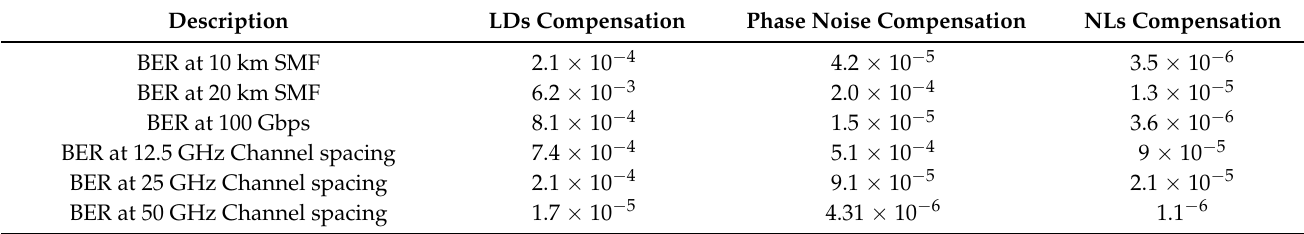
Figure 10. Optical spectrum analyzer. ( a ) Input transmitted signals. ( b ) Without managing of NLs, LDs, and phase noise at a 10 km length. ( c ) Without managing NLs, LDs, and phase noise at a 20 km length. ( d ) NL-, LD-, and phase-noise- compensated outcomes for a 20 km path cover. Table 2. Comparison of NLs, LDs, and phase noise at different conditions.